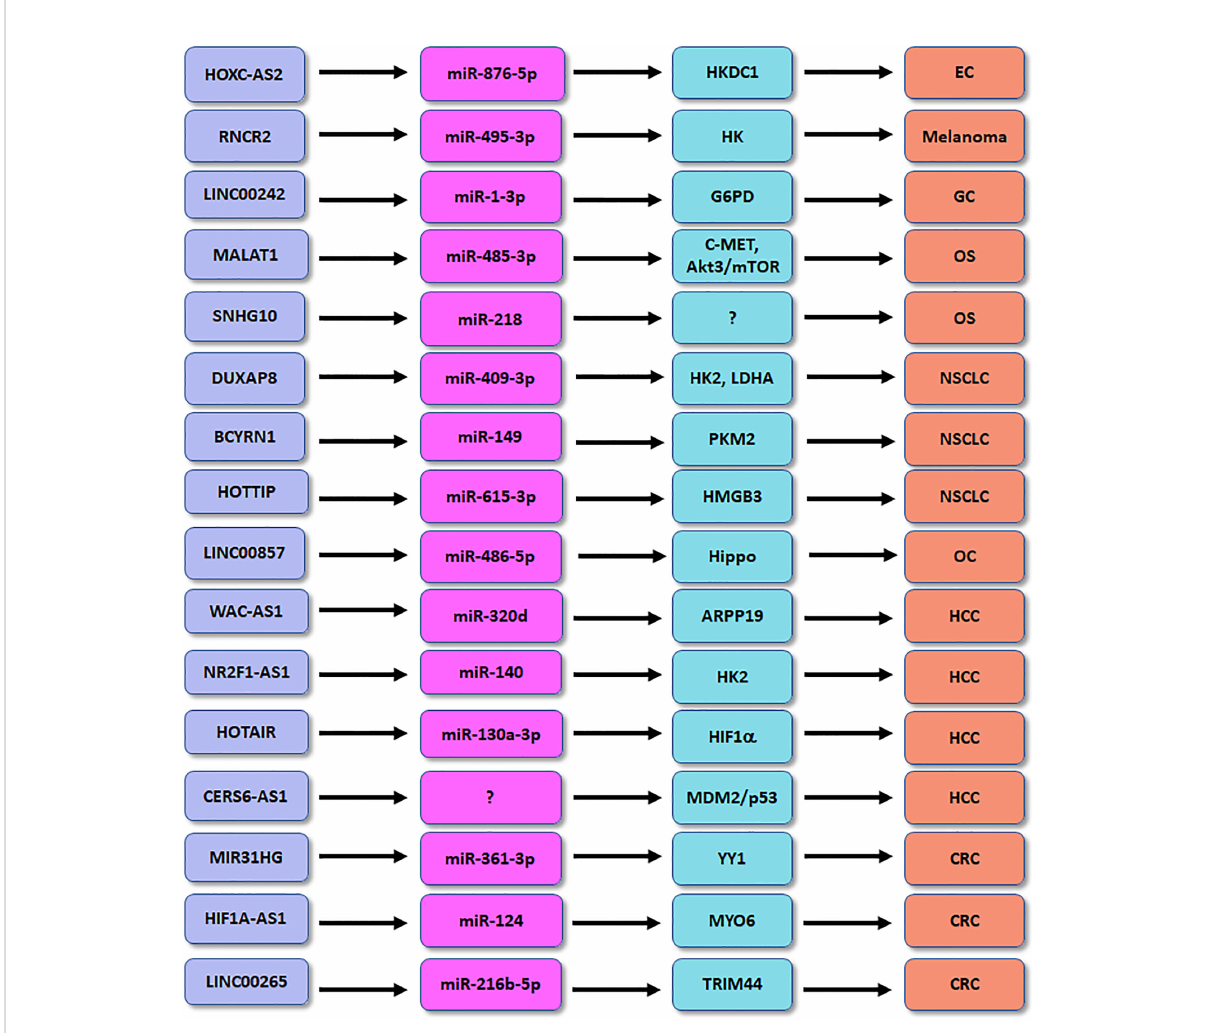
FIGURE 1 The role of lncRNAs in regulation of glucose metabolism in human cancers. EC, endometrial cancer; OS, osteosarcoma; HCC, hepatocellular carcinoma; CRC, colorectal cancer; GC, gastric cancer; NSCLC, non-small cell lung